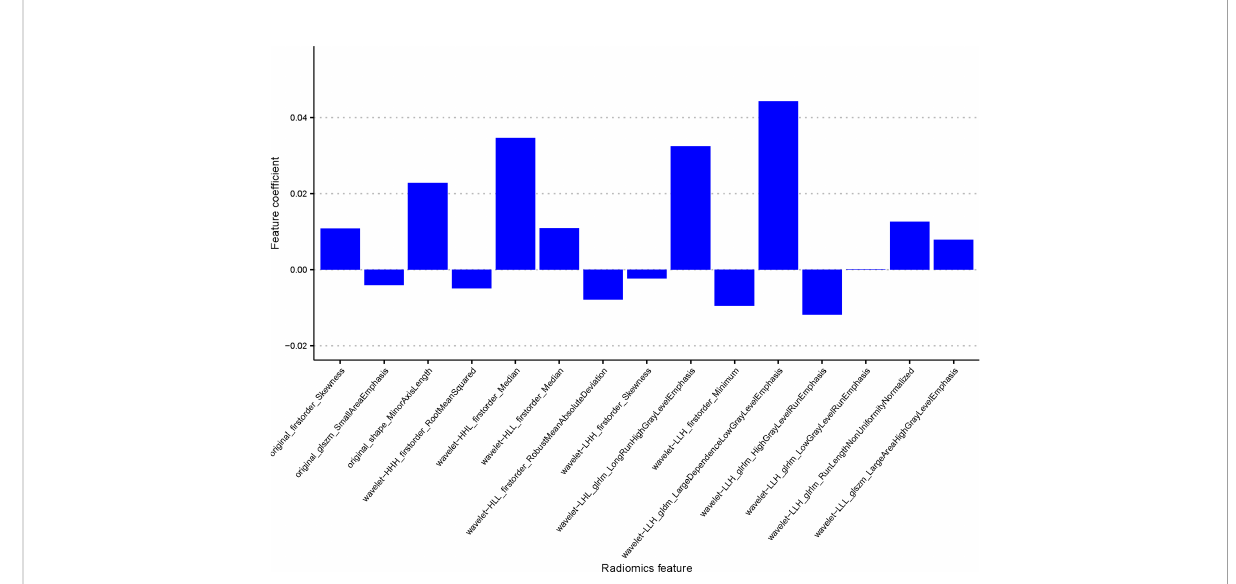
FIGURE 4 A non-zero coef fi cient pro fi le plot of the 15 selected radiomics features derived from the LASSO regression was